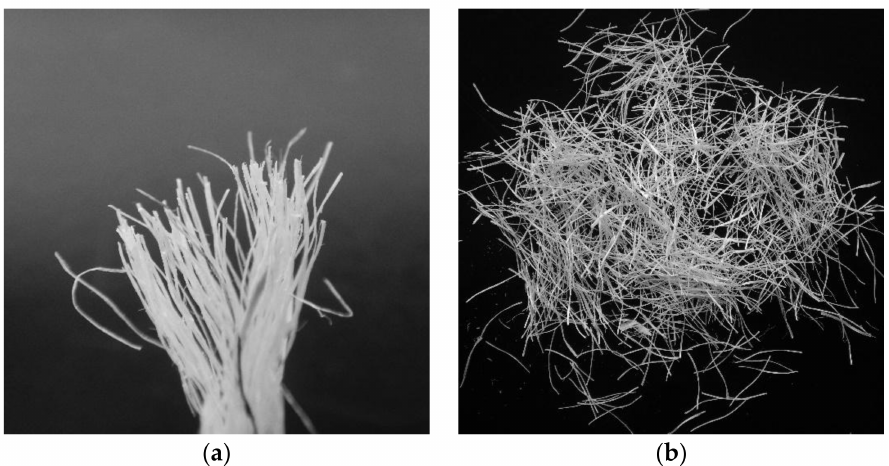
Figure 3. Fibers preparation steps: ( a ) unwrapped of spiral strand; ( b ) 13 mm short fibers after cutting.